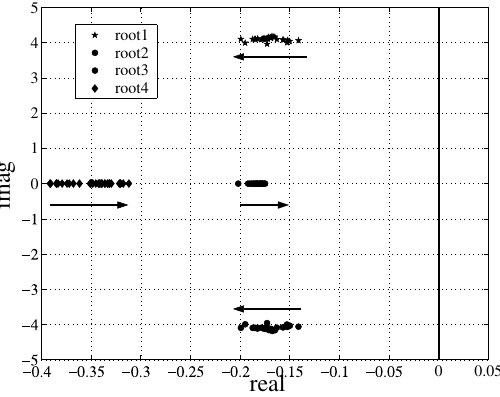
Fig. 7 Root locus